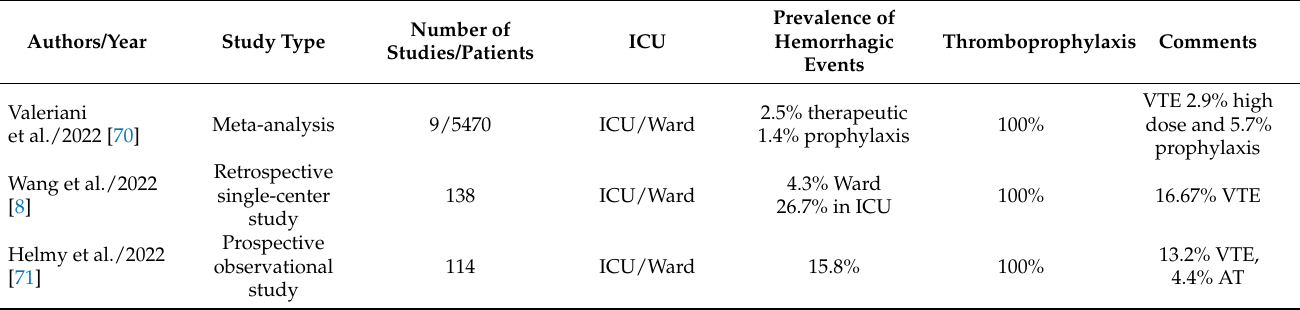
Table 3. Medical literature studies referring to hemorrhagic events – major